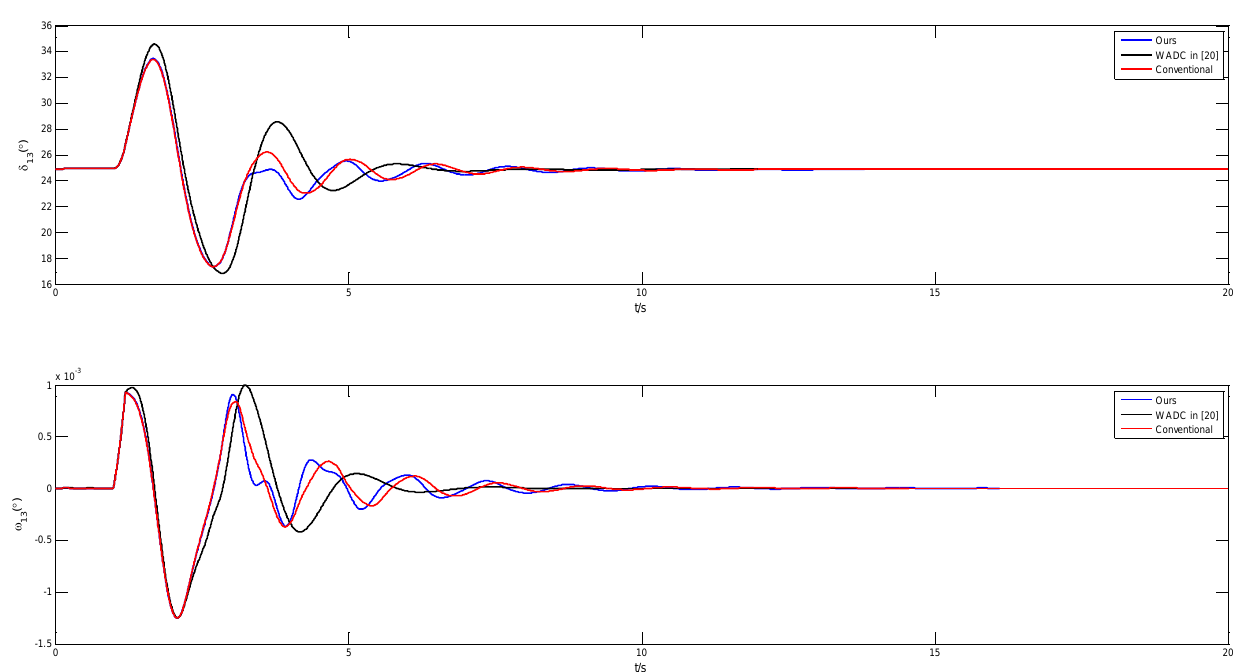
Figure 11. Response of the system in Scenario 1 when ρ = 0.1.